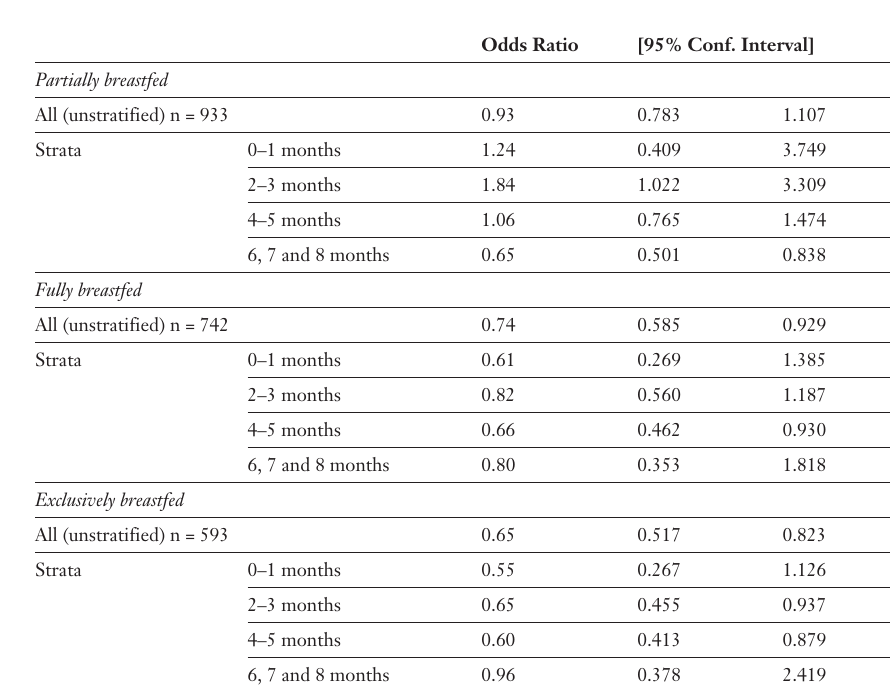
Table 4 Sensitivity analysis 1 – impact of breast- feeding types on vitamin D supple- mentation – stratified by age